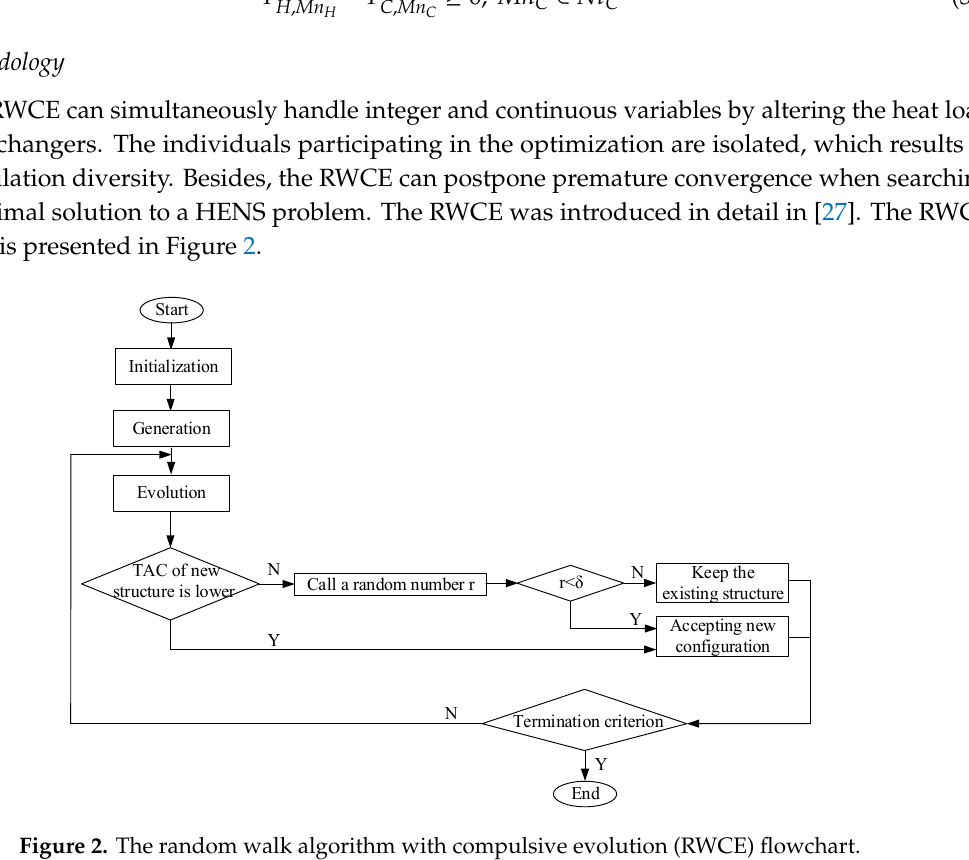
Figure 2. The random walk algorithm with compulsive evolution (RWCE) flowchart.